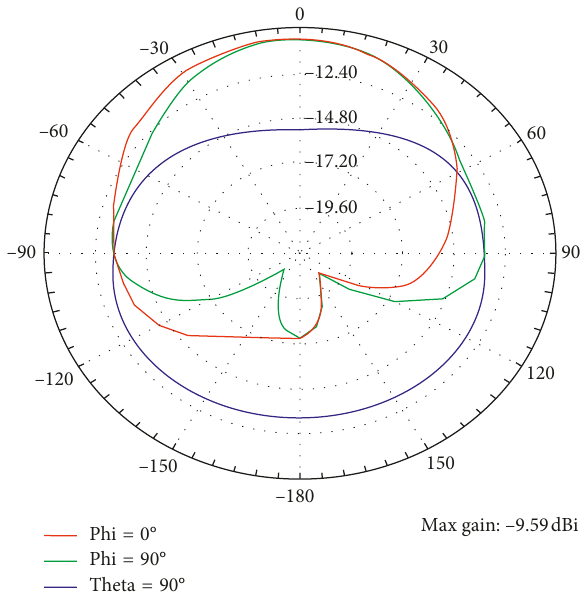
Figure 7: Radiation pattern (gain-total) in 2D of the proposed epidermal tag over the human body reference